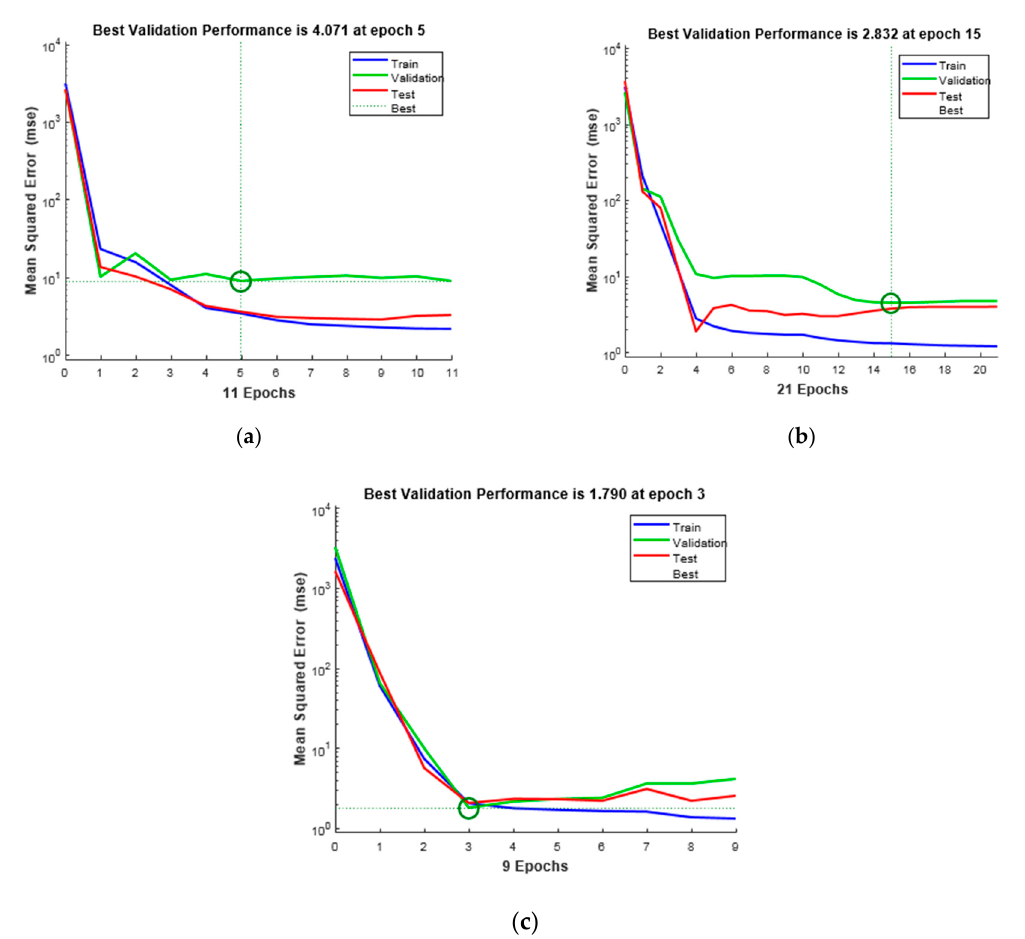
Figure 13. ANN parameter optimization using algorithm convergence. ( a ) P-wave; ( b ) P-, S- waves; ( c ) P-, S-, R- waves.